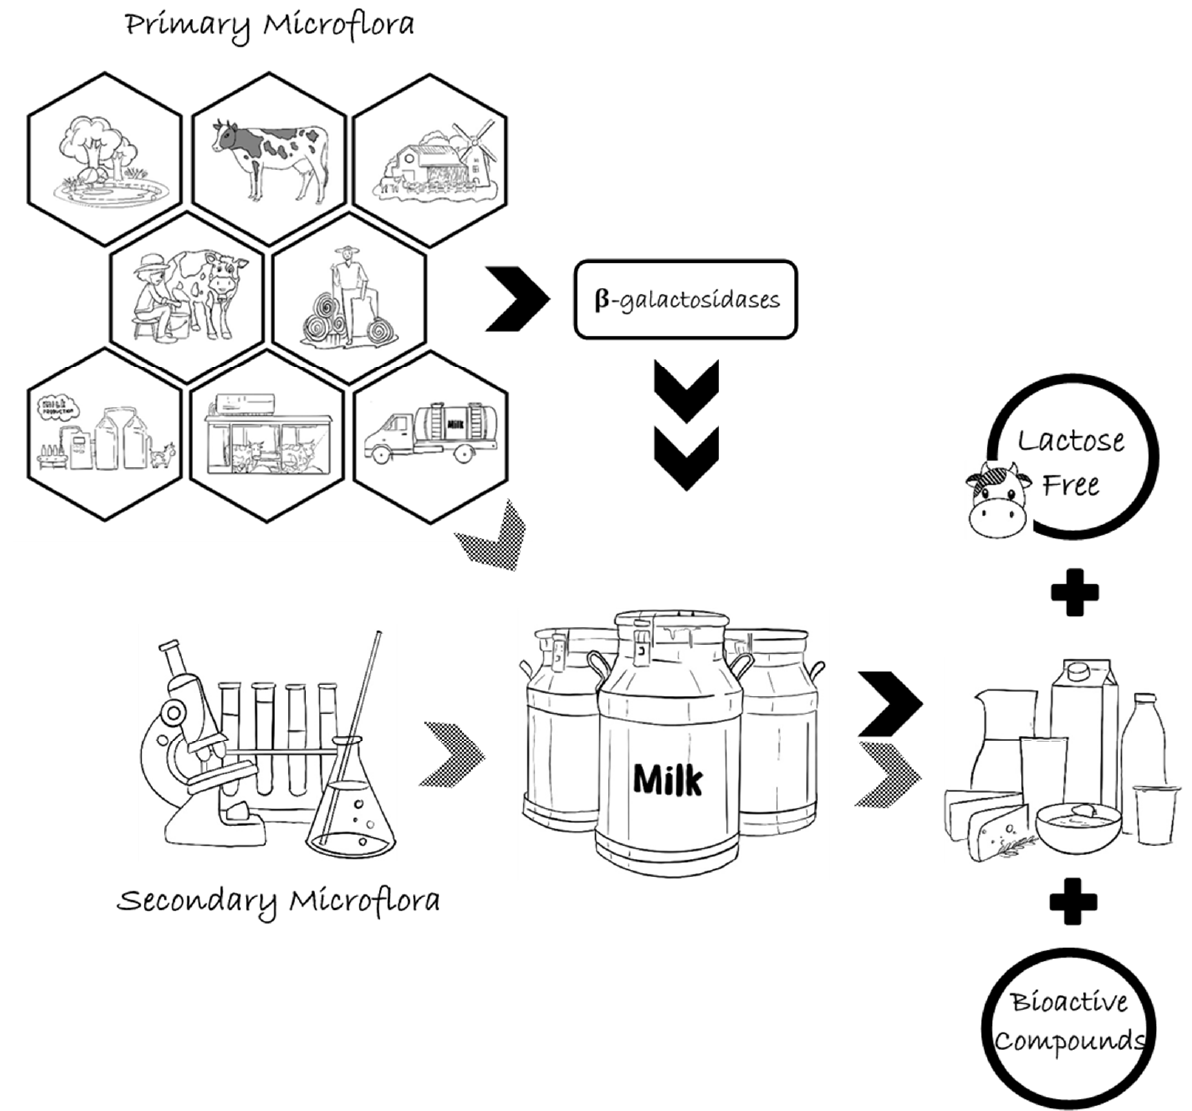
Figure 2. Potential origins of bacteria belonging to the genus Arthrobacter in milk and significant benefits of Arthrobacter spp. in the dairy industry.